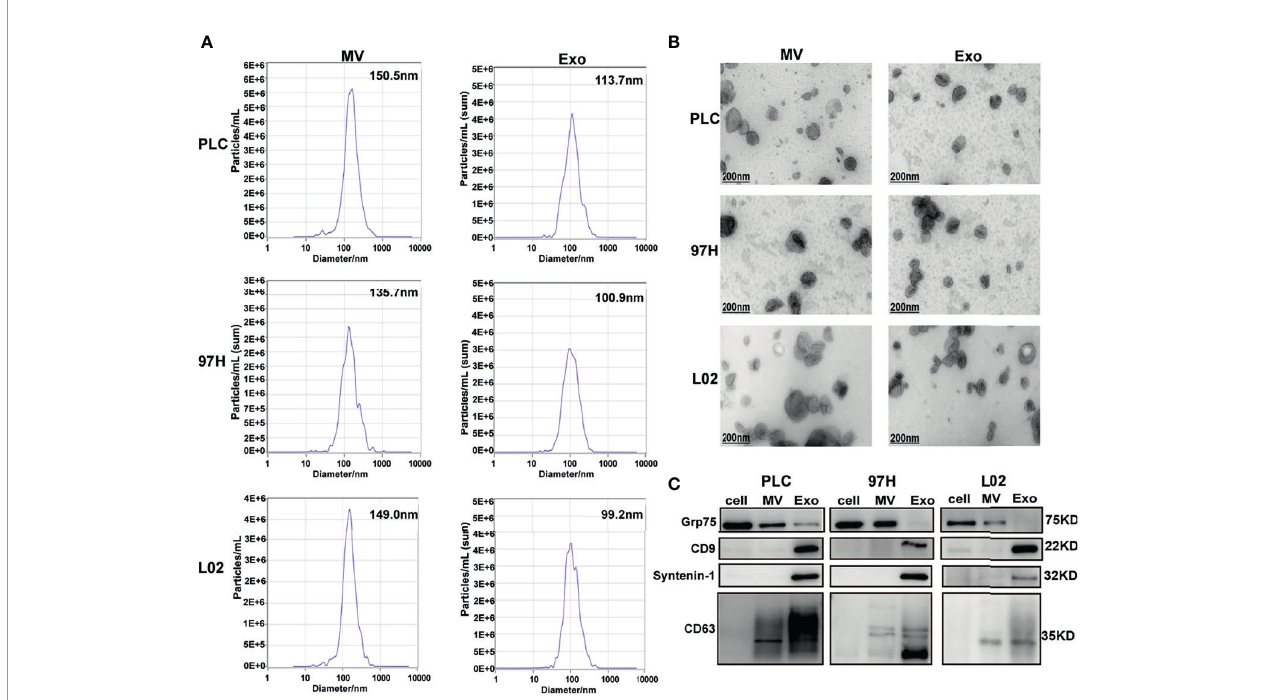
FIGURE 1 | Examine the extracellular vesicles (EVs) isolated from HCC cell lines PLC/PRF/5 and MHCC-97H, as well as normal hepatic cell line L2. (A) Nanoparticle tracking analysis of the sizes of the EVs isolated from the three cell lines. (B) Electron microscope images of isolated EVs isolated from the three cell lines. (C) Western blot analysis of extracellular vesicle markers on the EVs isolated from the three cell